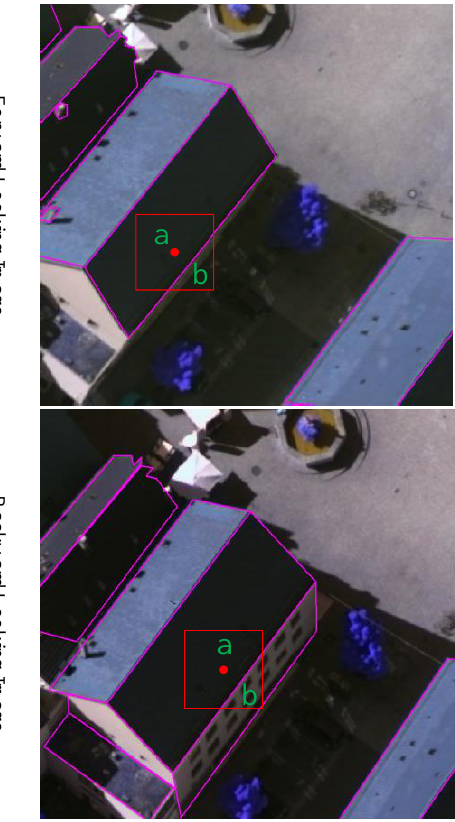
Fig.3 The typical decision conflict of the